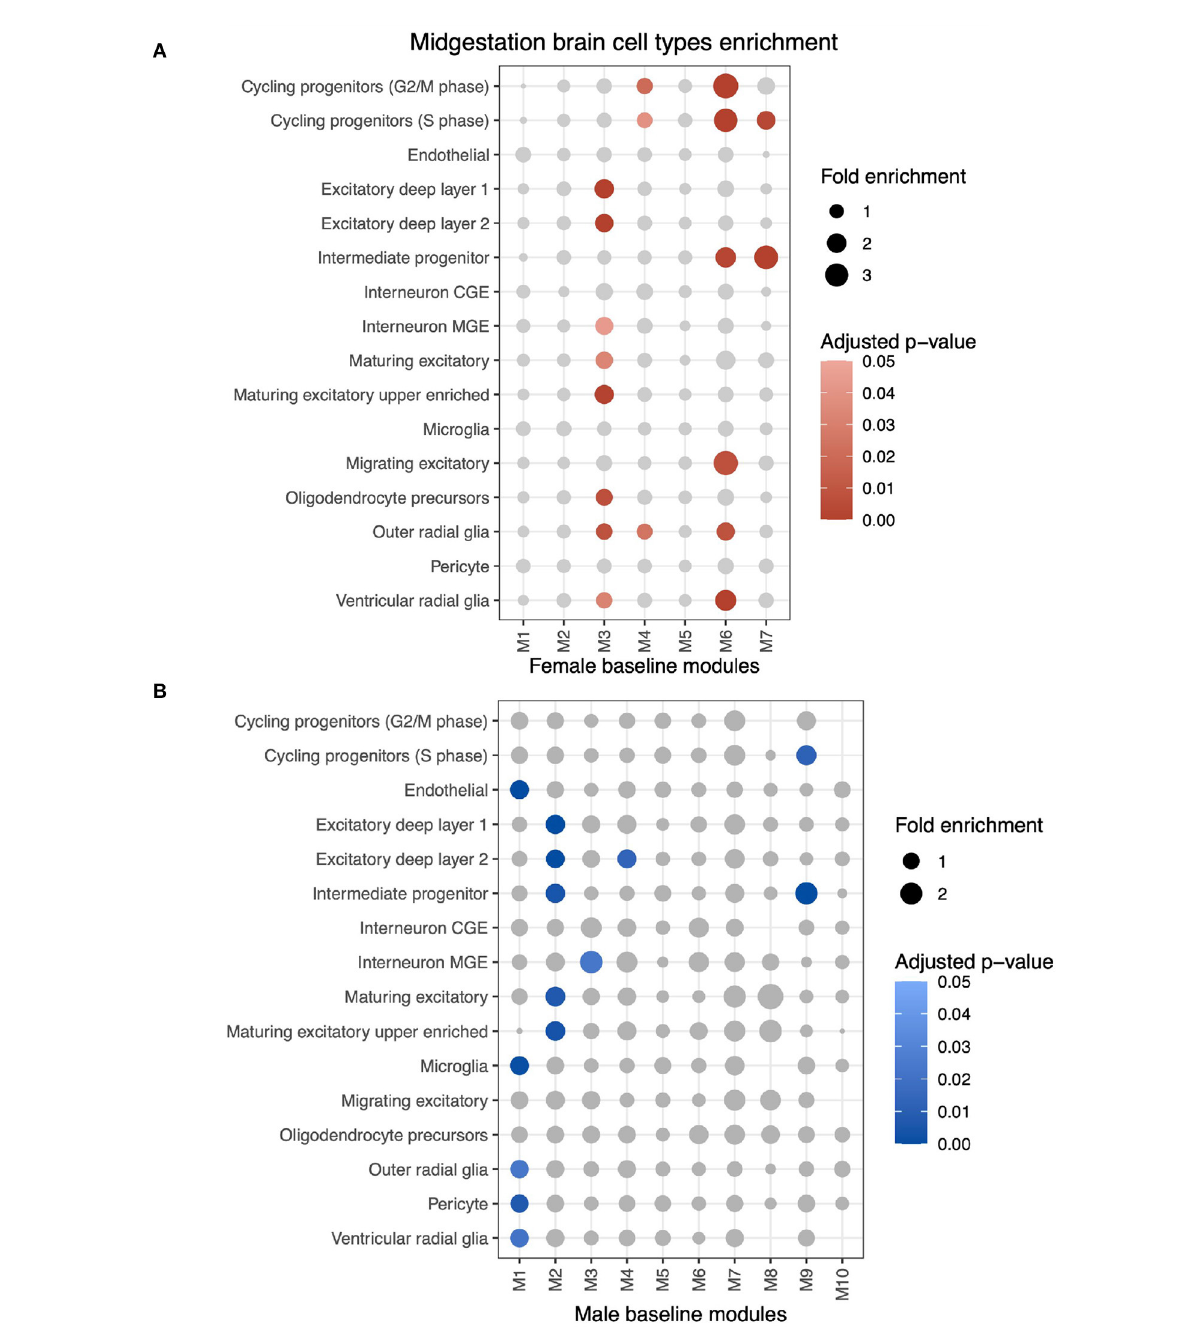
FIGURE5 MSET analysis of all genes from differential modules for enrichment of mid-gestational cell types identified by fetal brain single-cell RNA-seq. (A) MSET analysis of genes from differential modules using the female network as the baseline. Circle size indicates module gene fold enrichment of the cell type dataset and significant enrichment (adjusted p < 0.05) is represented by the red scaled colors. (B) Cell type results using the male differential network.